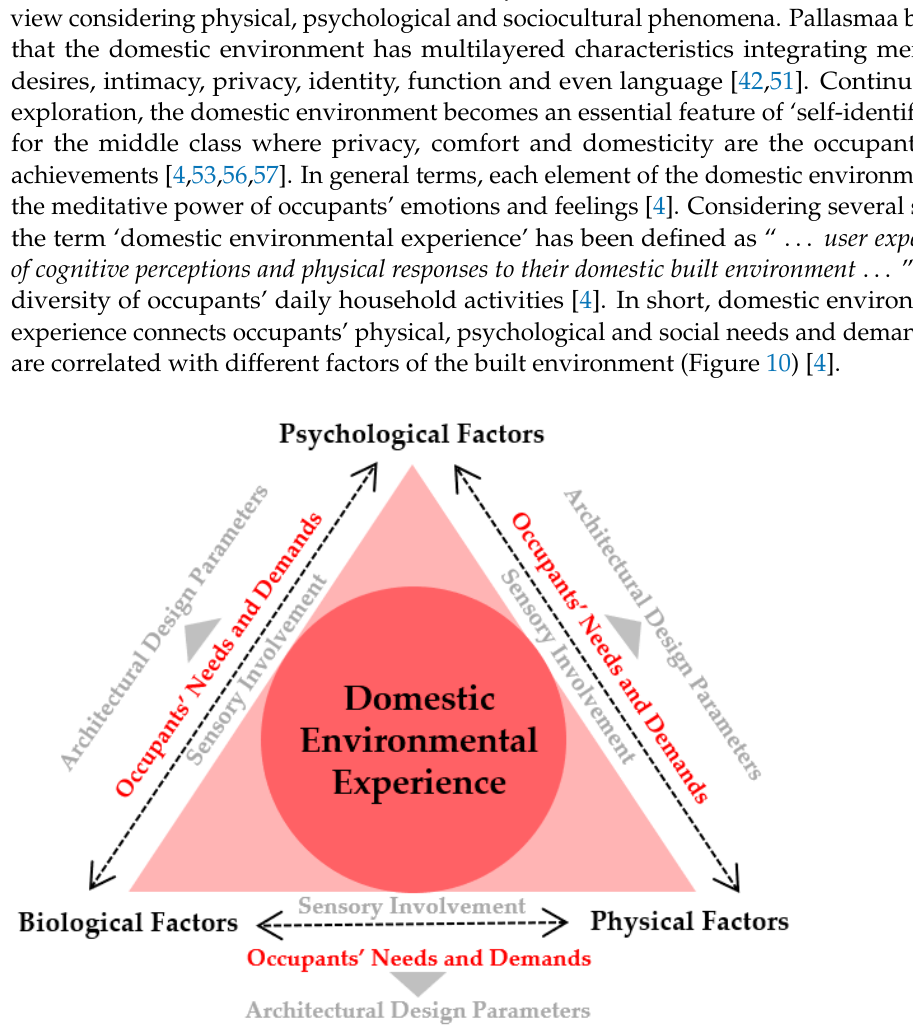
Figure 9. Domestic environment and occupants’ psychological responses. Source: [2,4,5,39,40,43,56].